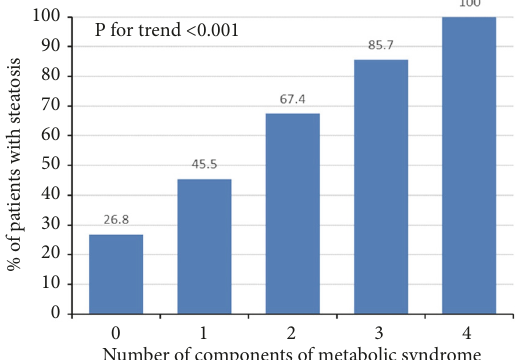
Figure 2: The prevalence of nonalcoholic fatty liver disease (NAFLD)as detectedby ultrasoundin relationship tothe numberof components of metabolic syndrome (final cohort, N=159 patients). There is a statistically significant trend of increase in proportion of NAFLD among patients with rising number of metabolic syndrome components, the Χ 2 test for trend, P <